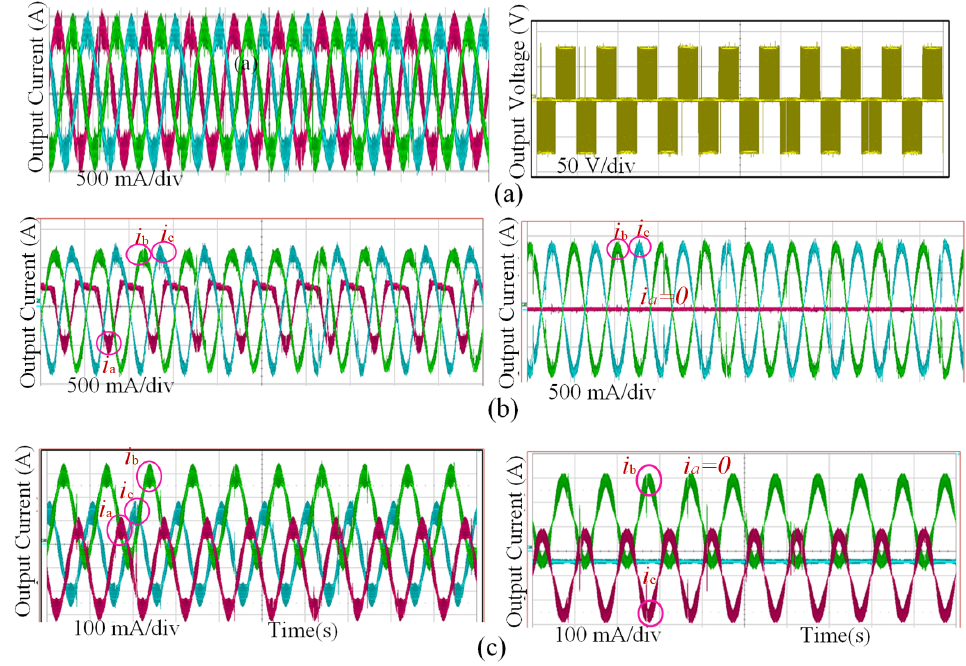
Figure 12. Experimental waveforms: ( a ) normal operation, ( b ) open-circuit fault, and ( c ) short- circuit